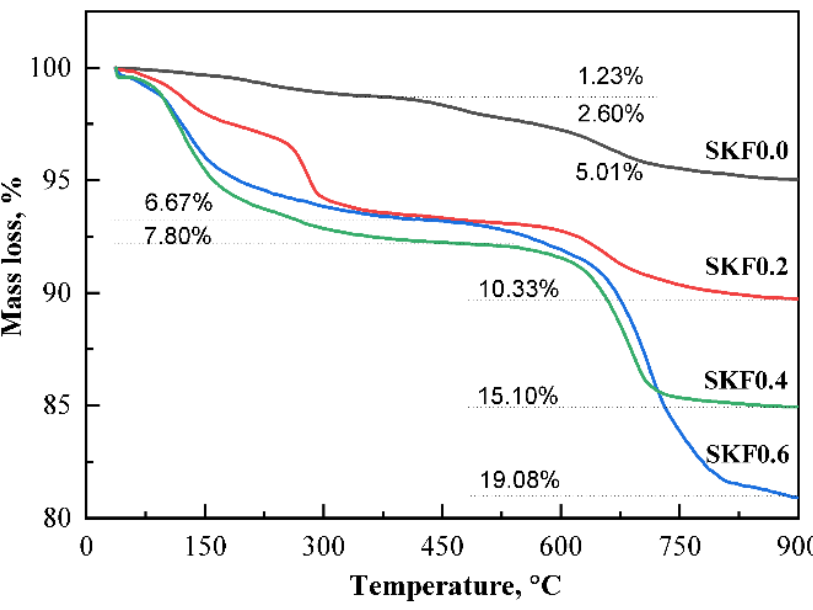
Figure 3. Thermogravimetric analysis of the SKFx (x = 0, 0.2, 0.4, 0.6) catalysts from ambient temperature to 900 ◦ C under the inert atmosphere.